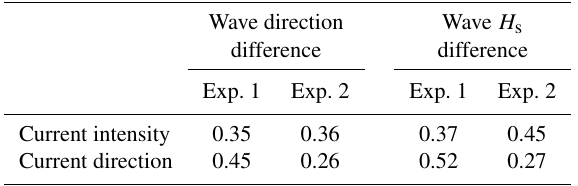
Table 2. Spatial mean correlation factors between the difference in wave direction and significant height ( H s ) for the WAVECOUPLE and WAVEFORCE forced modeling strategies and the surface cur- rent intensity and direction. Only correlations significant to the 99% level were taken into consideration. Wave direction difference Exp. 2 Current intensity 0.35 0.36 0.37 0.45 Current direction